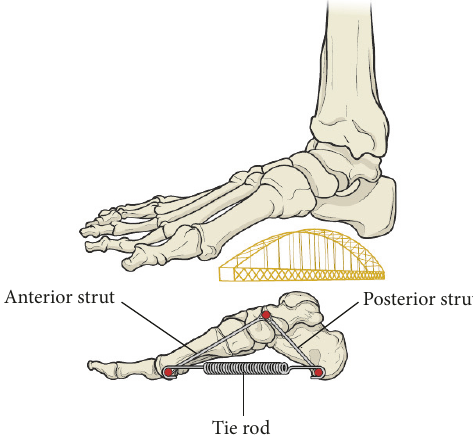
Figure 1: The arch of foot mechanism